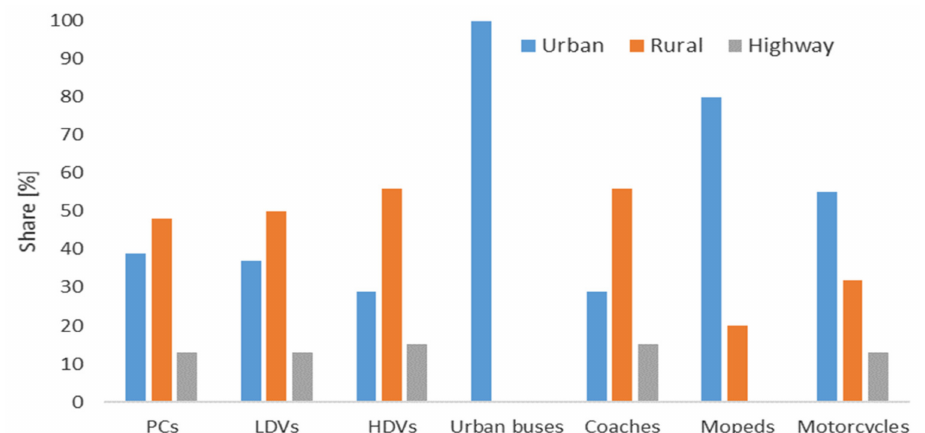
Figure 1. Mileage share for each road class in Poland in 2020 [20].